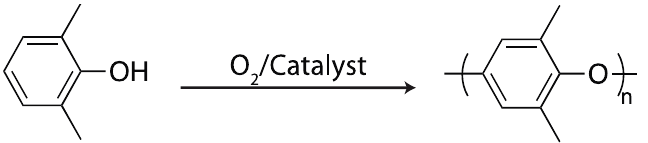
Figure 11. The polymerization of 2,6-dimethylphenol into a poly(phenylene oxide) via oxidative coupling